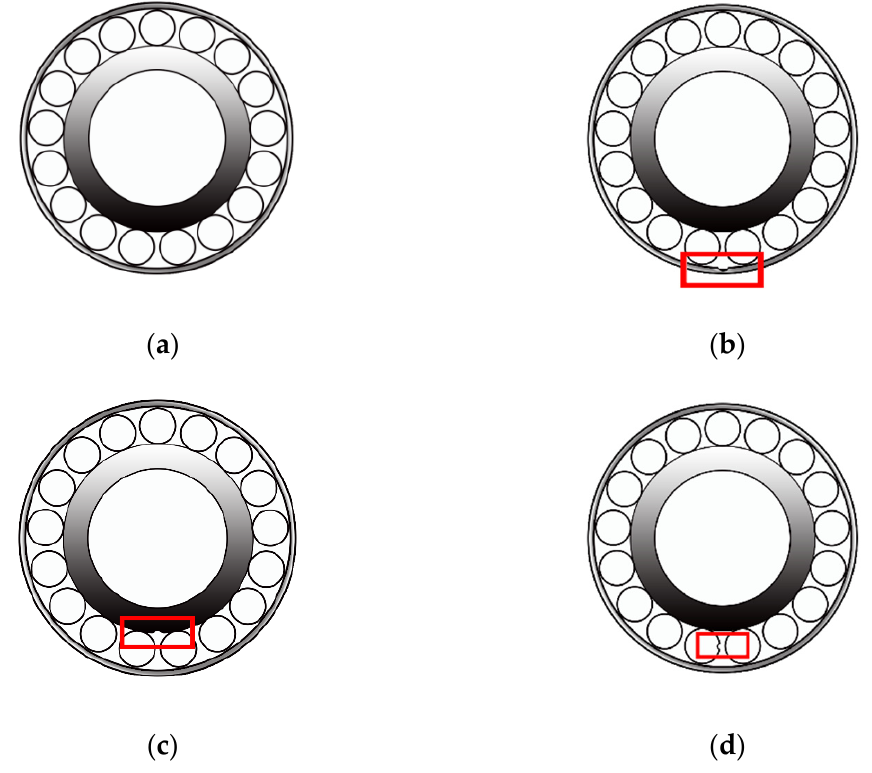
Figure 2. Schematic diagram of axle box bearing: ( a ) schematic diagram of normal Bearing; ( b ) schematic diagram of outer ring fault bearing; ( c ) schematic diagram of inner ring fault bearing; ( d ) schematic diagram of roller fault bearing.